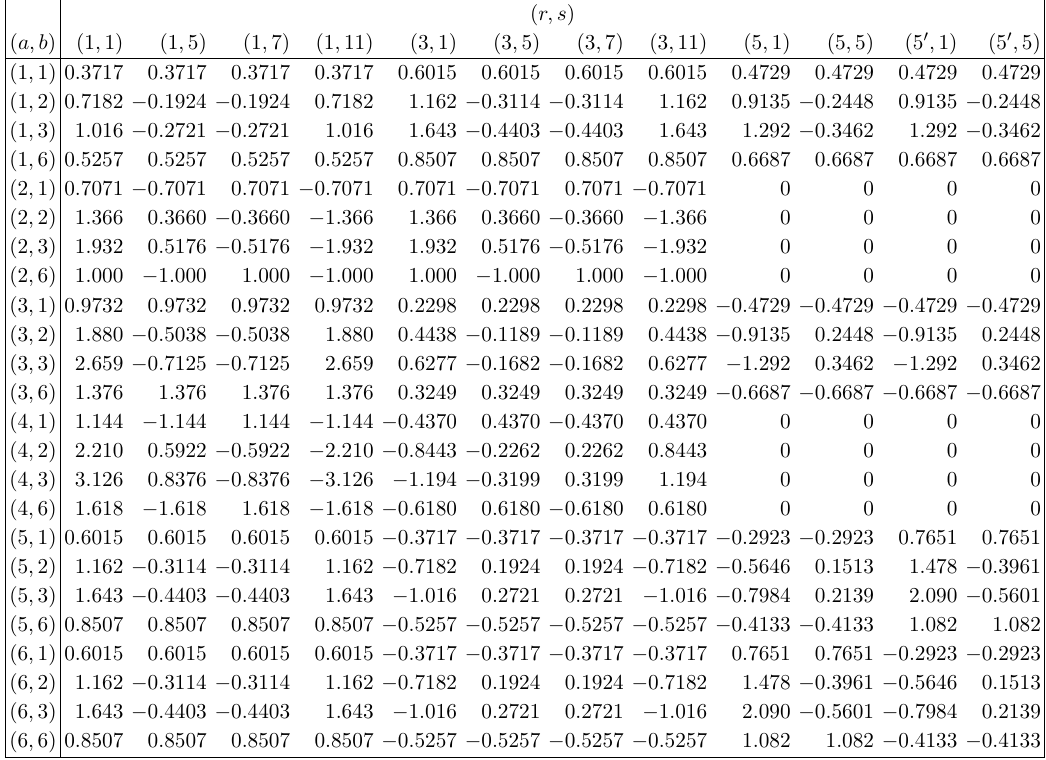
Table 8 . Numerical values of the boundary state coe(cid:14)cients (cid:9) ( a;b )